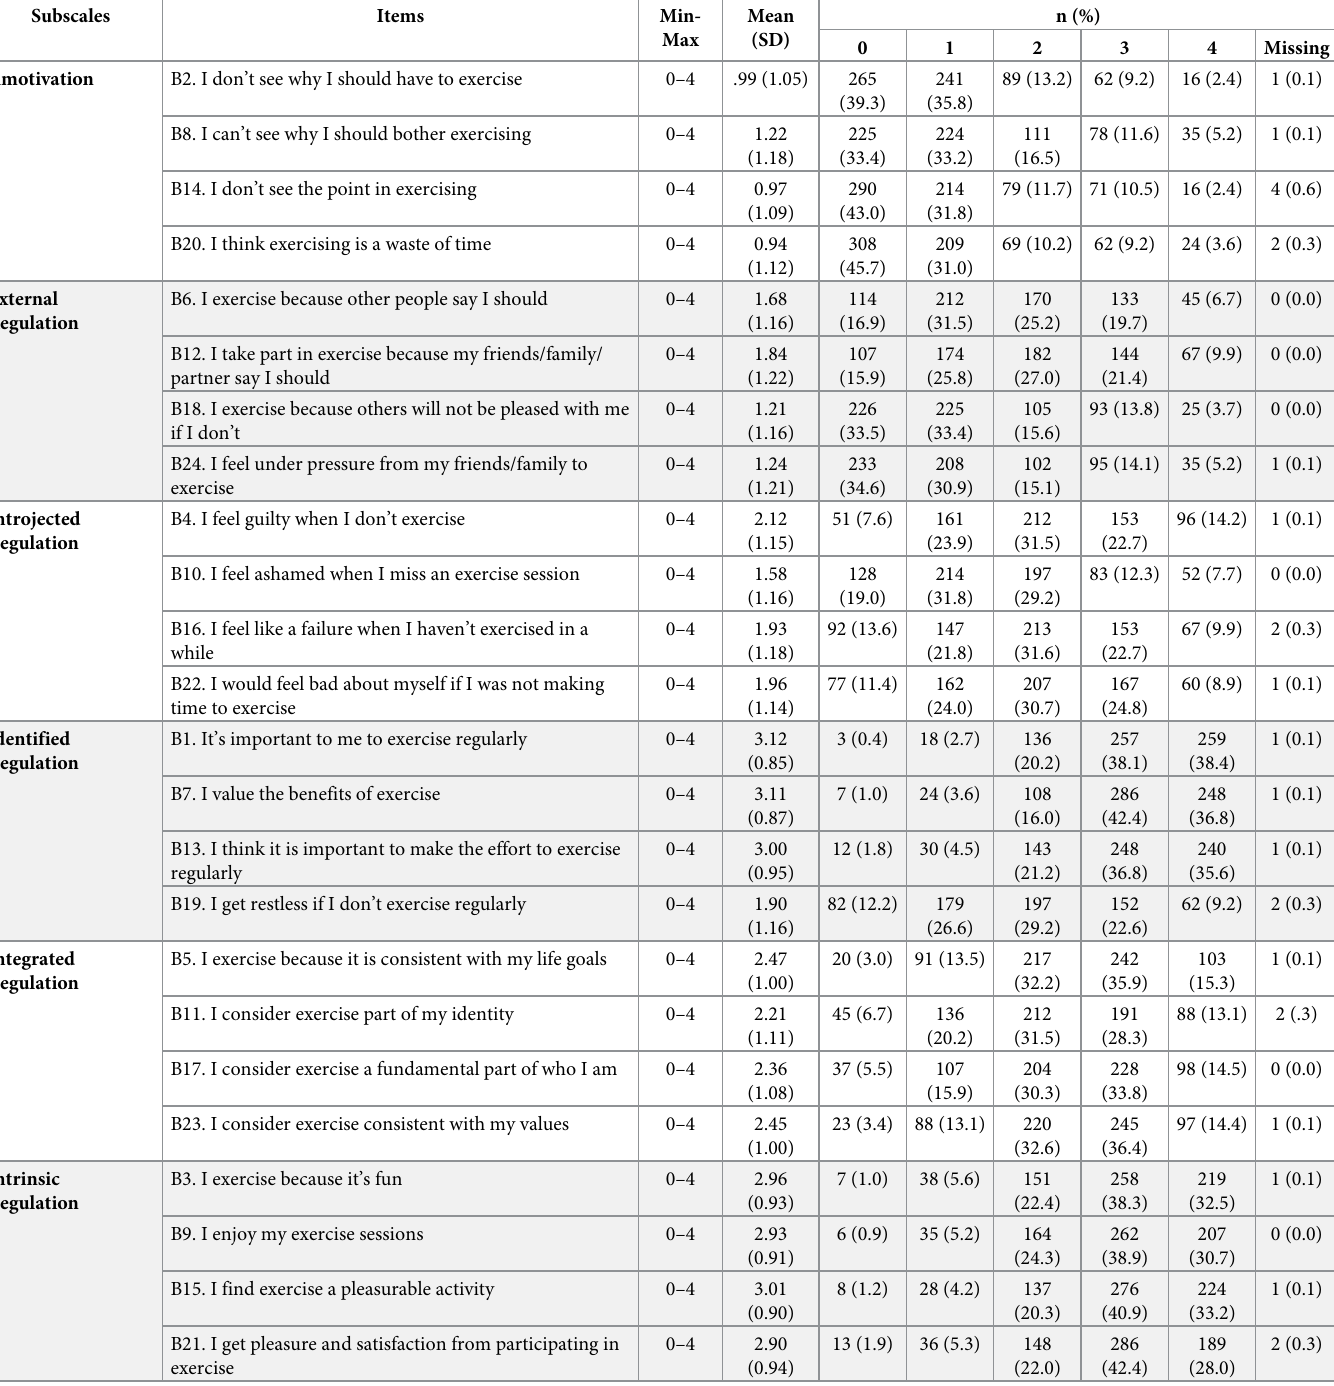
Table 1 summarises the distribution of items of BREQ-3M. The hypothesised measurement model for the six-factor BREQ-3M consisted of 24 items. The results for the initial Table 1. Distribution of items in